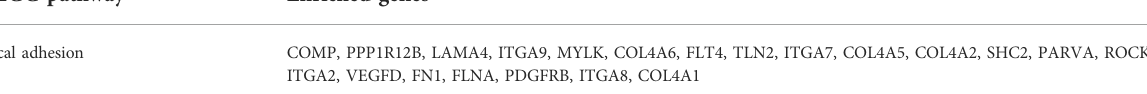
TABLE 1 The enriched genes in the KEGG pathway of focal adhesion signaling pathway. KEGG pathway Enriched genes Focal adhesion